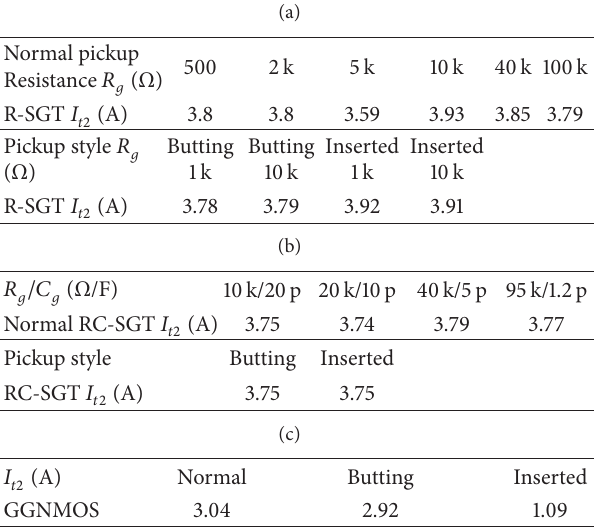
Table 1: (a) Resistance SGTNMOS 𝐼 𝑡2 with different pickup